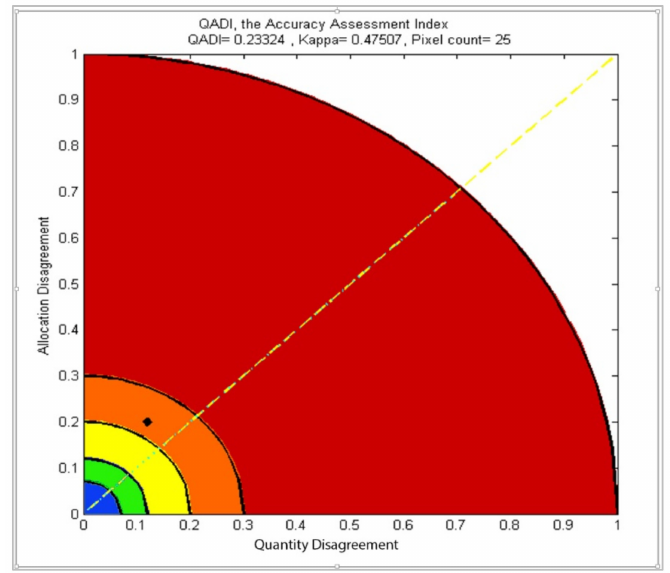
Figure 2. Quantitative analysis of the level of confidence in the computed Kappa.